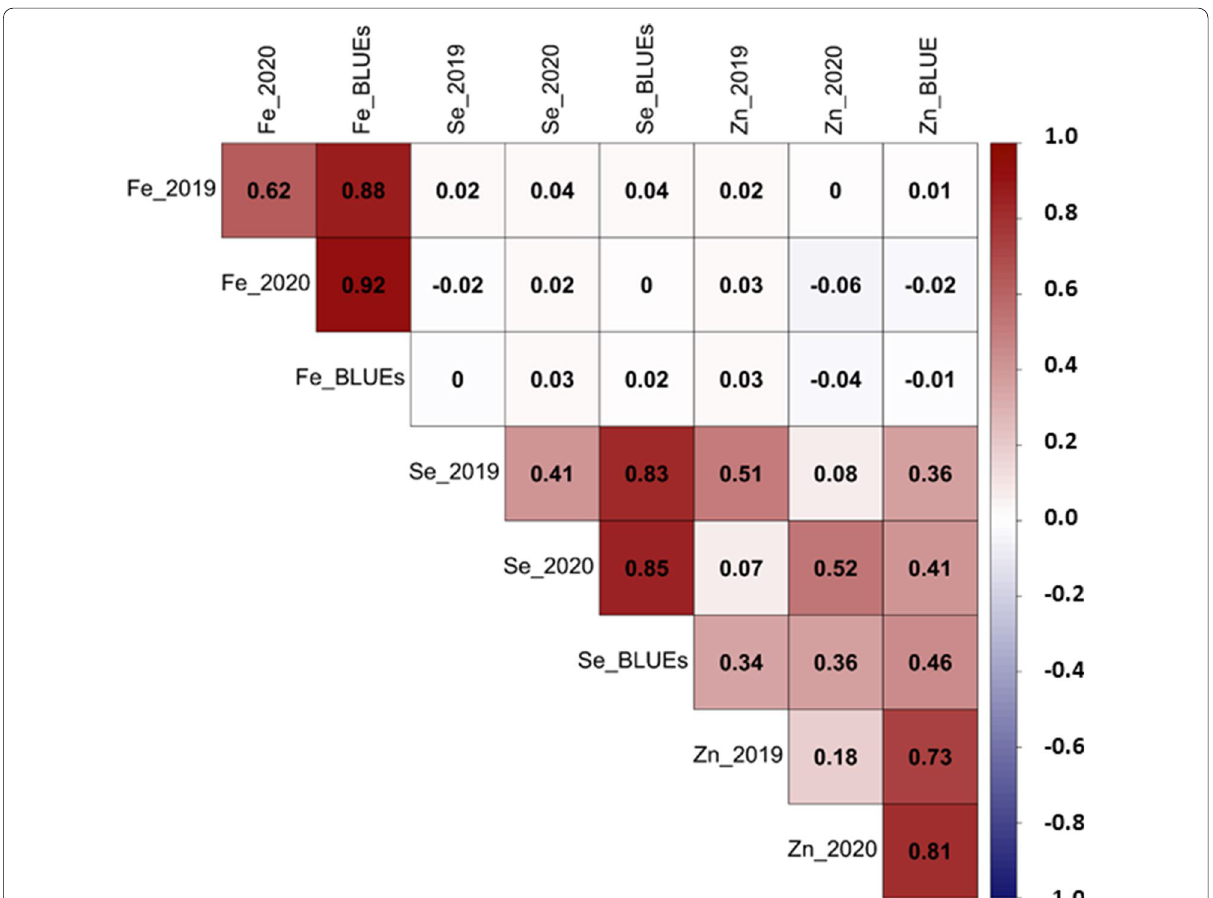
Fig. 5 Correlations of all the studied traits including Zn, Fe and Se for each year (2019/2020) and BLUEs in spring